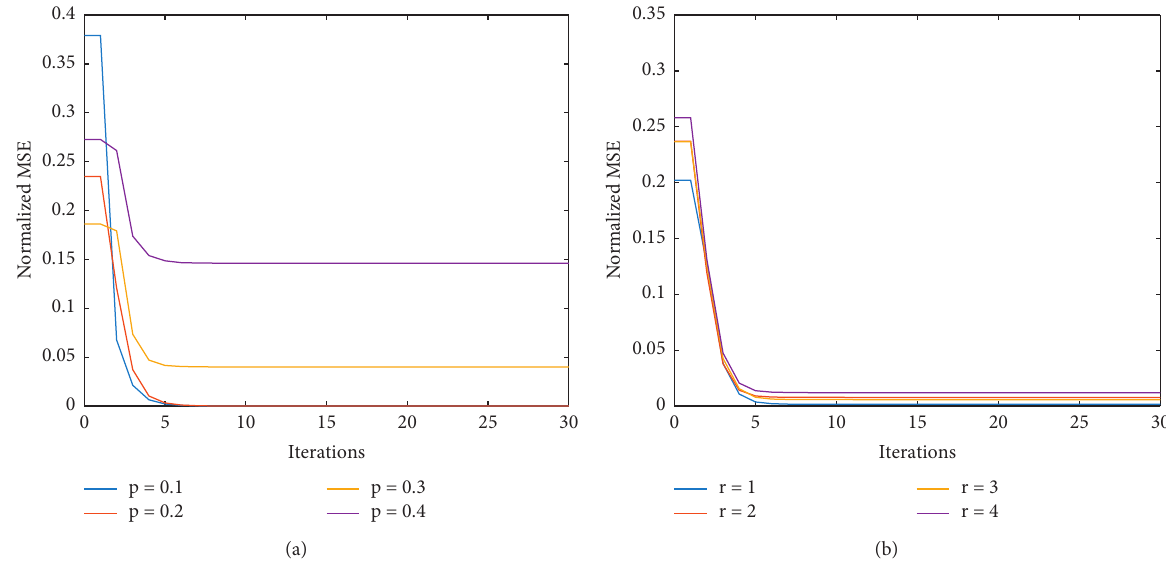
Figure 5: Convergence of the low-rank PatchMatch algorithm. (a) The convergence under different noise ratios (p) (the matrix rank (r) is fixed to 1). (b) The convergence under different ranks (r) (the noise ratio ( p ) is set to